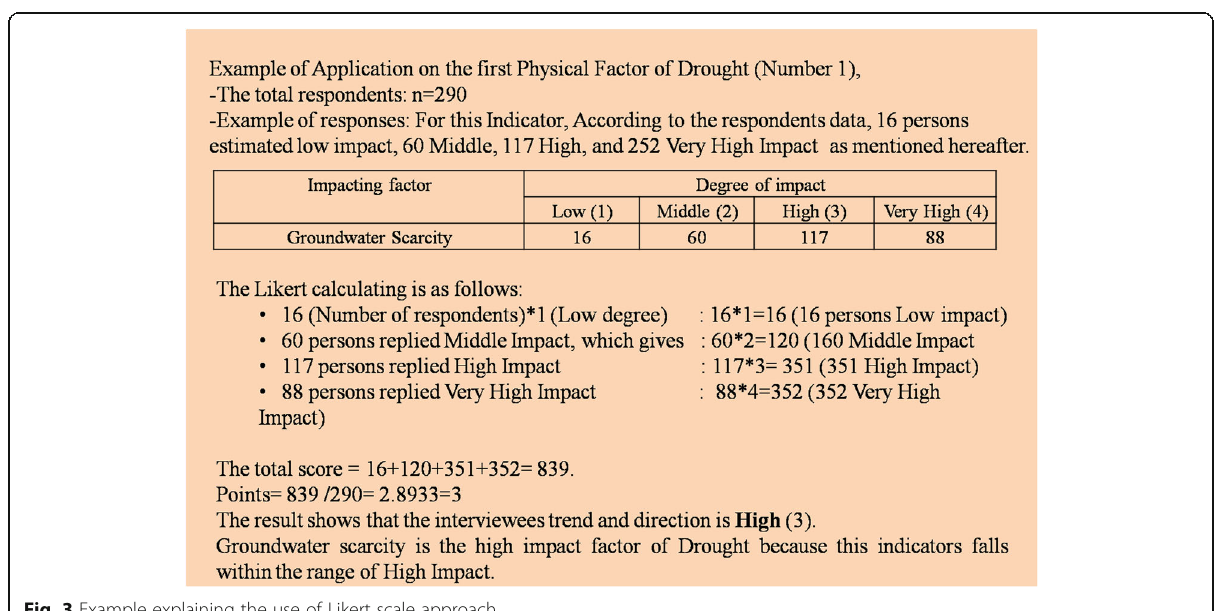
Fig. 3 Example explaining the use of Likert scale